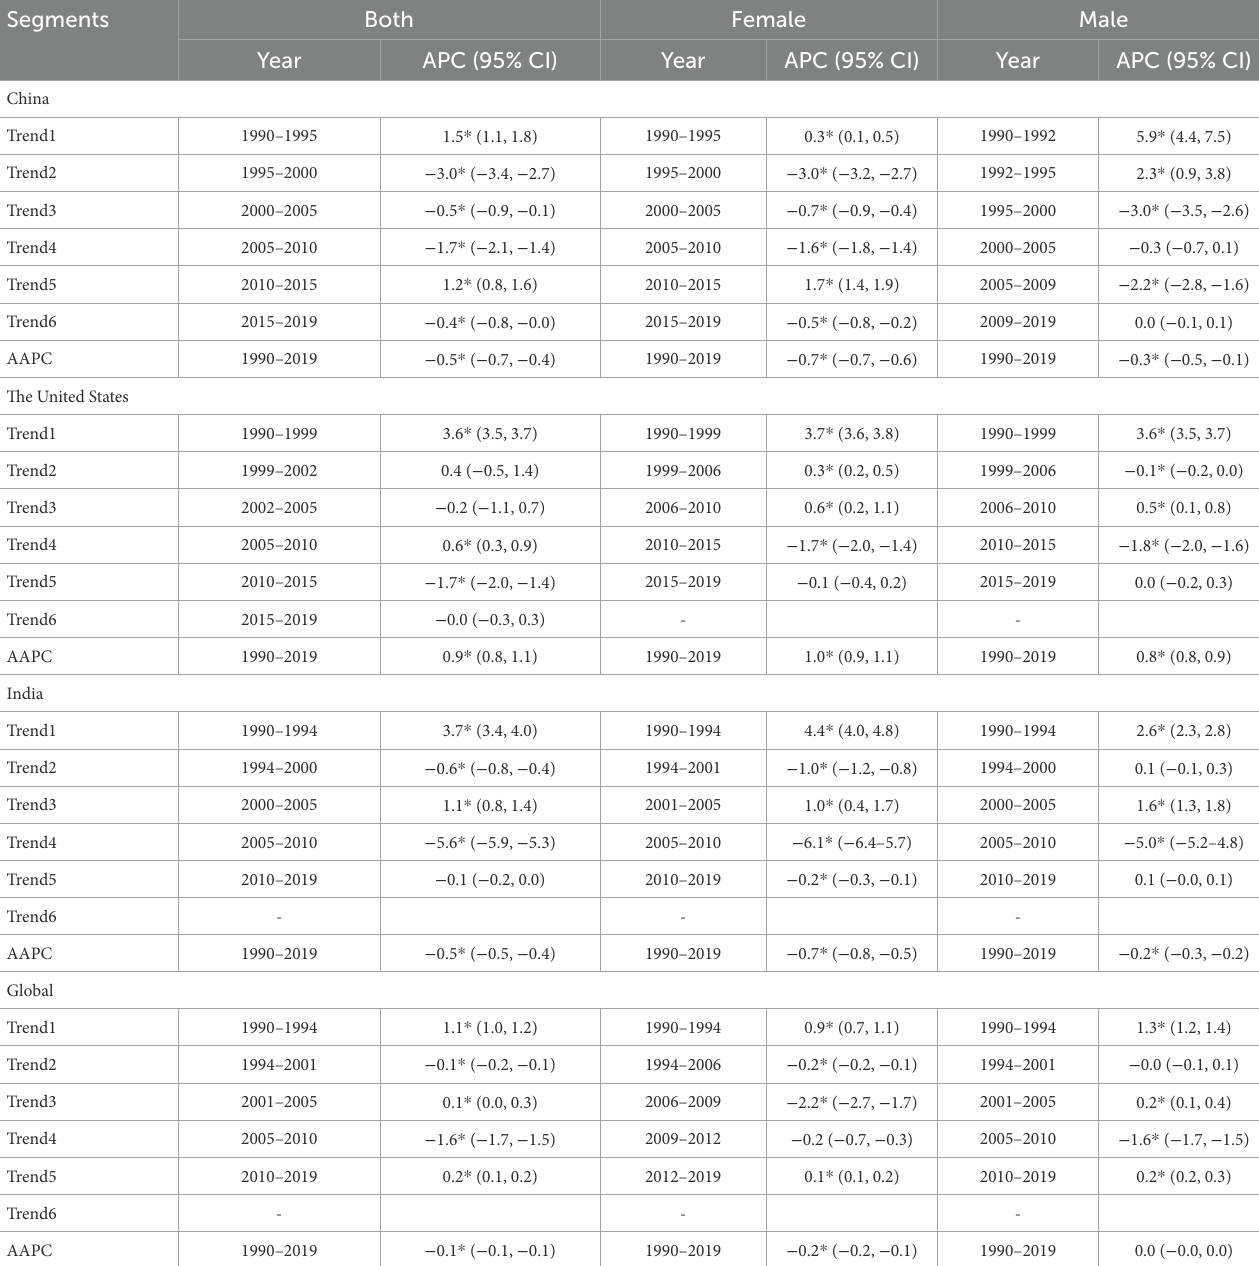
TABLE 2 Trends of age-standardized incidence rates for depressive disorders in the whole population, males and females in China, the United States, India and the global, 1990 to 2019. Segments